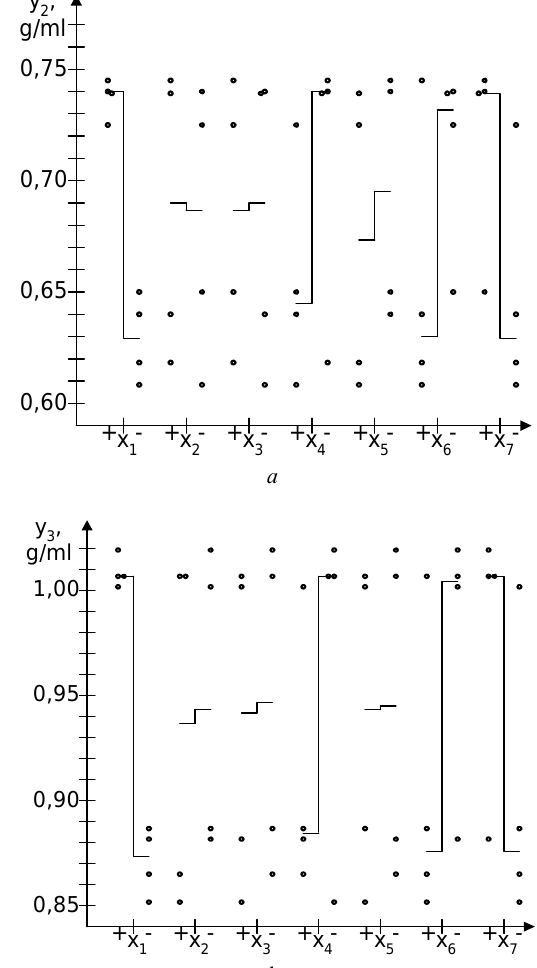
Fig. 1. Diagram of dispersion of the influence of quantitative factors on the density of the powder: a – on the bulk density; b – on the density after shrinkage Loss in mass during drying is an important indica- tor of quality, especially in the process of storing powder in sachet packs. High moisture content can cause the powders to soften and impair their characteristics. The influence of quantitative factors on mass loss during drying (y ) is shown in Fig. 2. 7